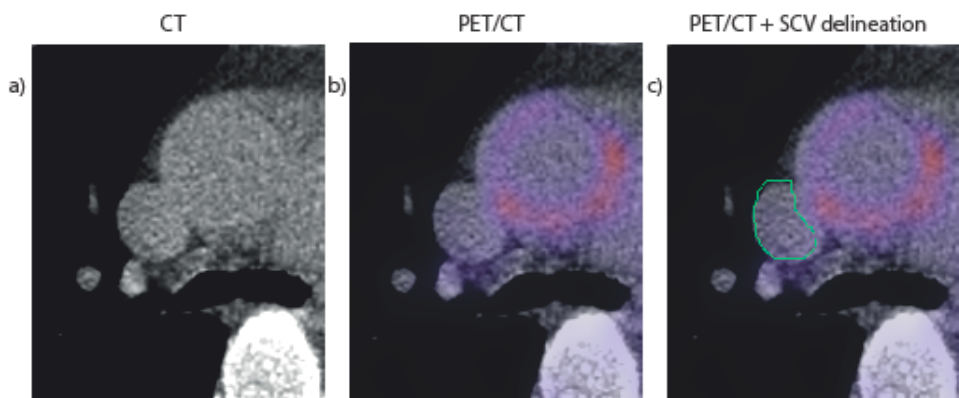
Figure 1. Axial slice of the superior caval vein (SCV) on a CT only ( a ), on the CT and PET fused ( b ), and the PET/CT with the SCV manually delineated, while carefully excluded the spillover from the heart next to it ( c ).